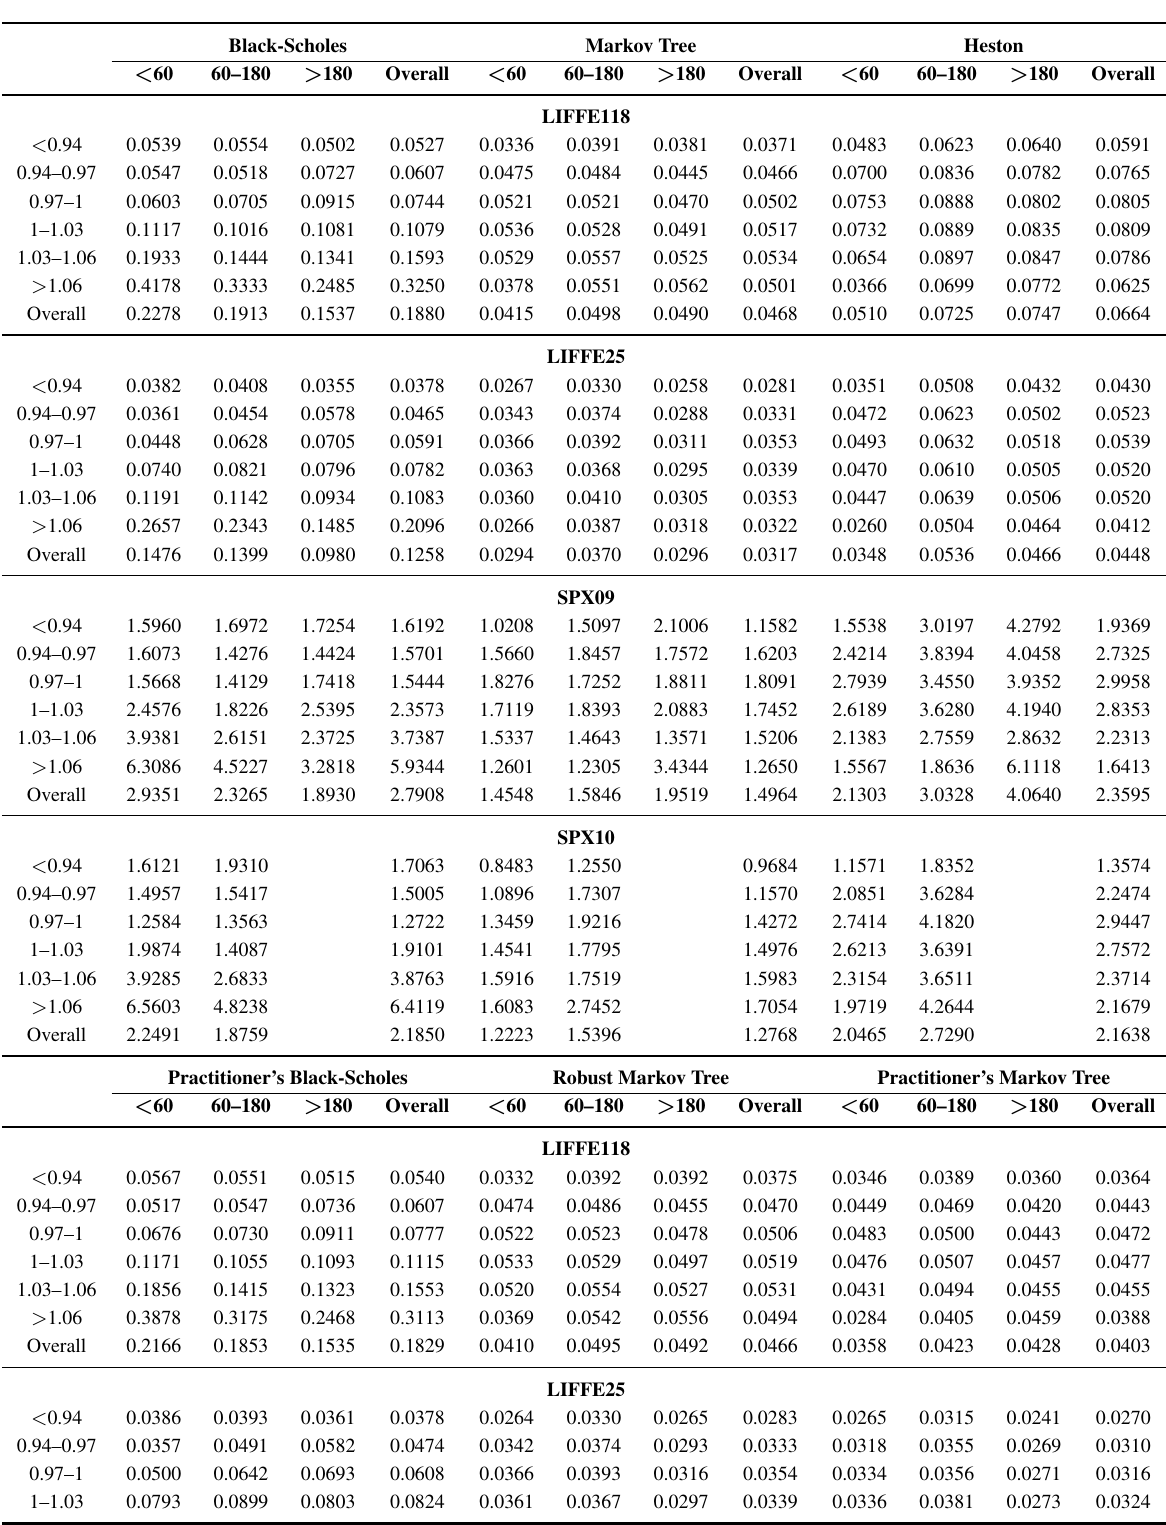
Table 2. For each of six models and four data sets (given in boldface), we provide out-of-sample hedging errors binned by moneyness and maturity. Rows and